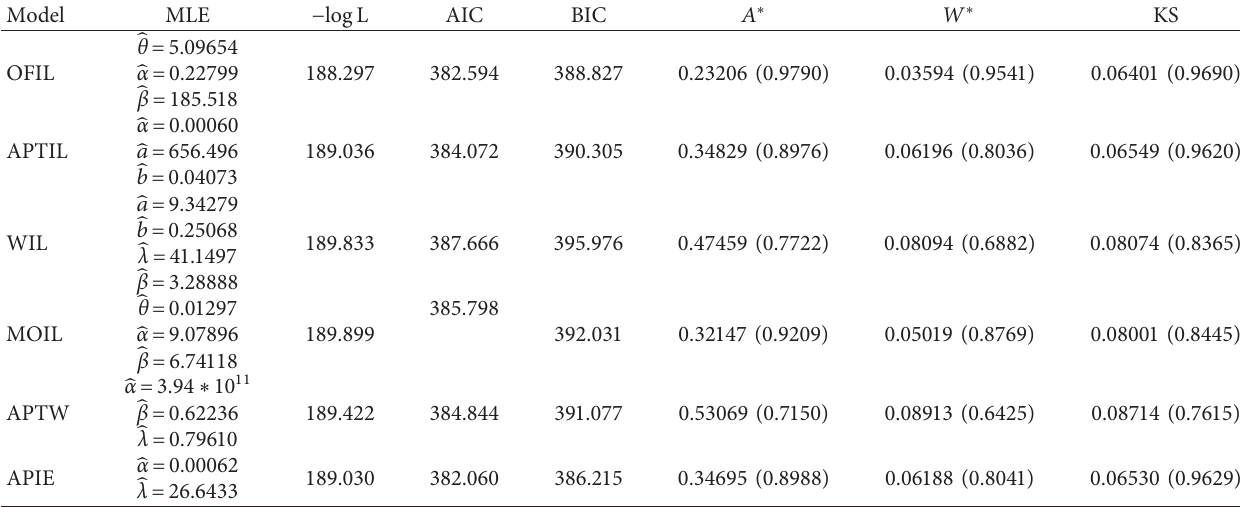
Table 12: ML estimates along with goodness of fit for data set II.